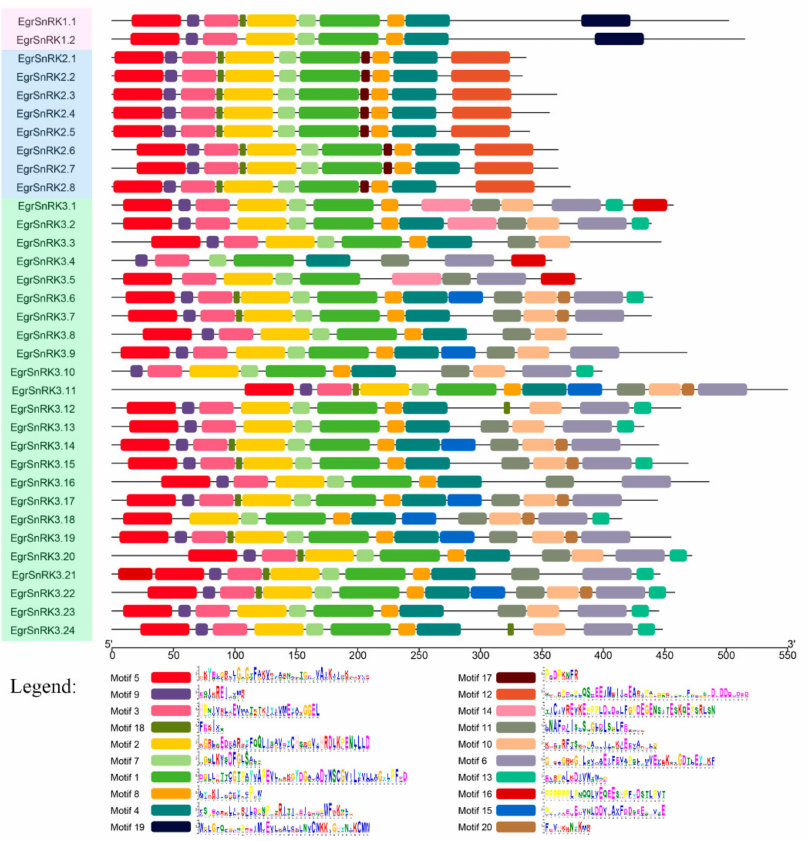
Figure 4. Conserved motifs of SnRK genes in E. grandis . Distribution of the 20 conserved motifs in the EgrSnRK genes following MEME analysis. The di ff erentially colored boxes represent di ff erent motifs and their position in each sequence of